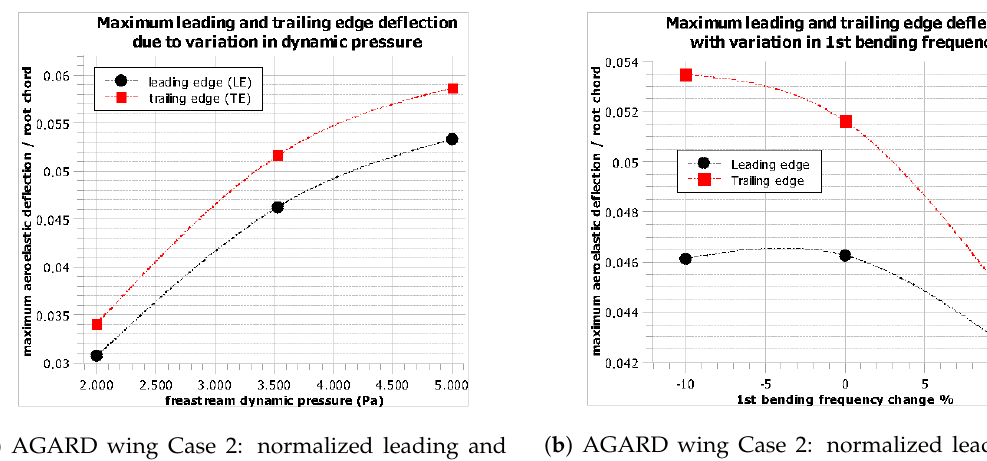
Figure 14. Applicability of the ROM to variations in important parameters.